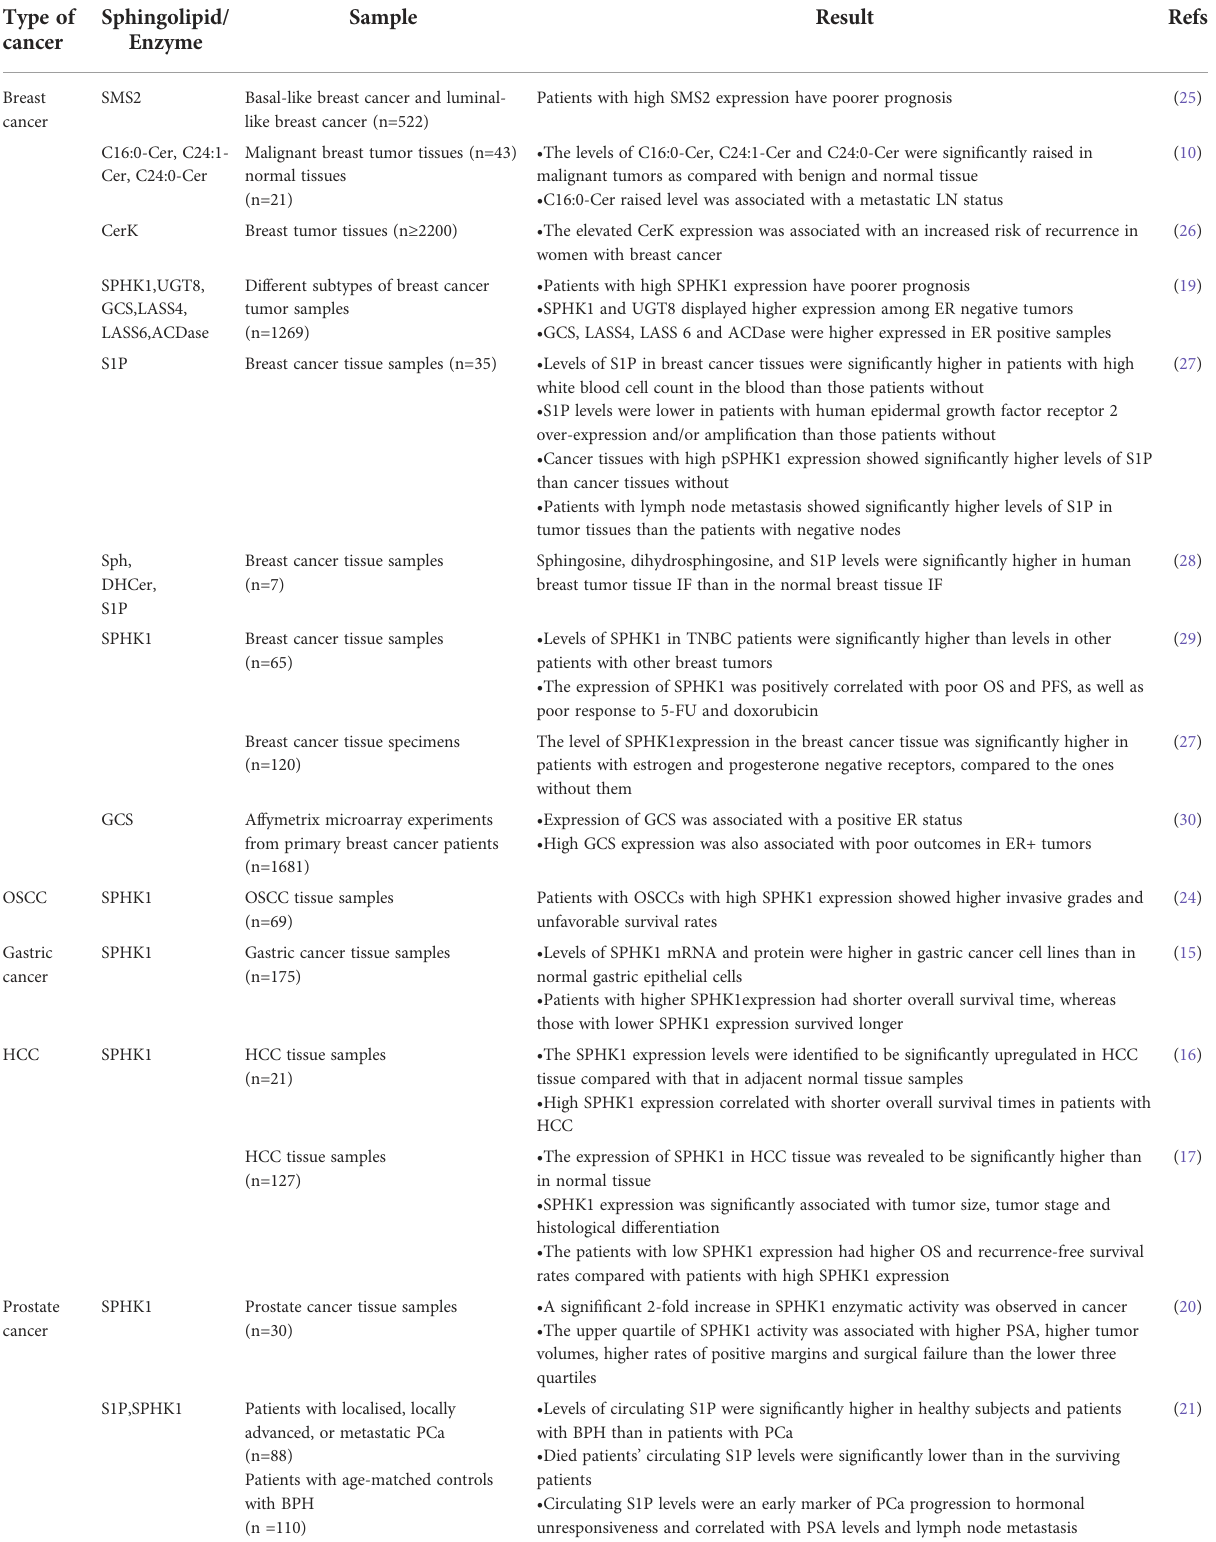
TABLE 1 Summary of sphingolipid biomarkers in various